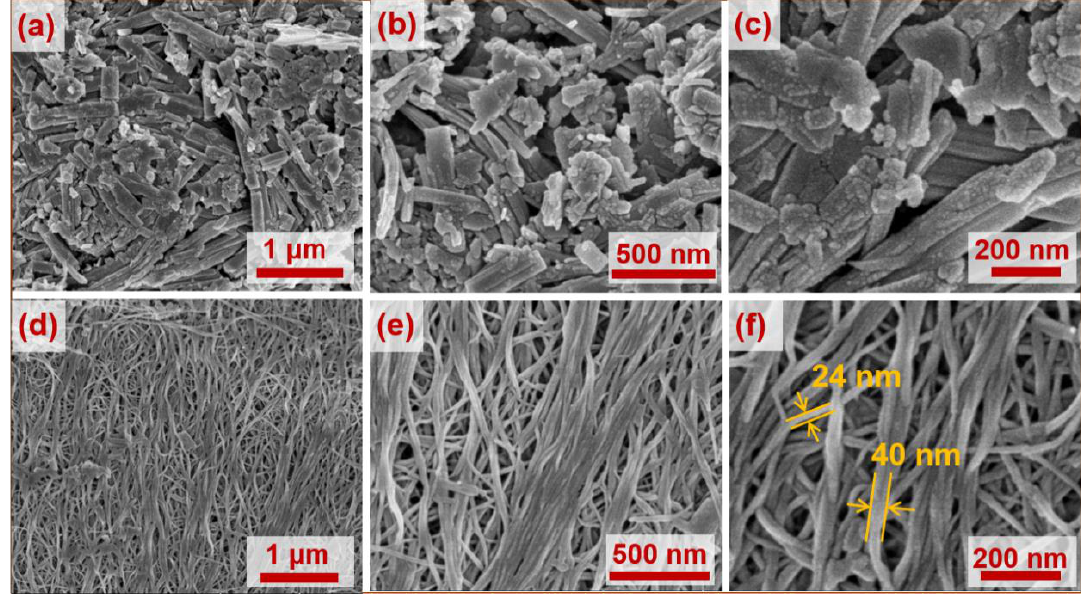
Figure 3. SEM images of the as-prepared ( a – c ) rod-like and ( d – f ) network WO 3 ·H 2 O material with different magnification.